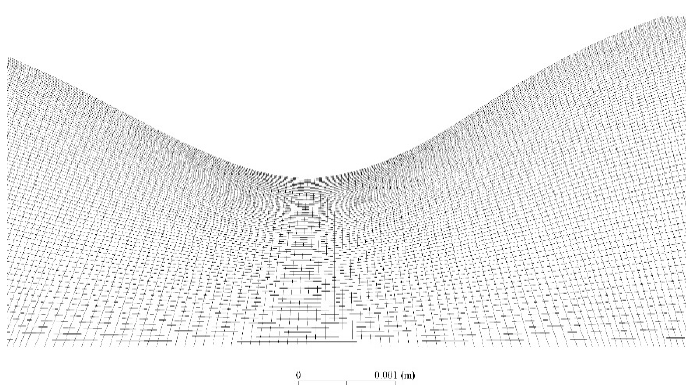
Figure A1. Details of the computational mesh in the nozzle throat (whole domain was filled with quadrilateral cells stretched in the flow direction, mesh is finer close to the walls to capture the velocity gradient within the boundary layer).